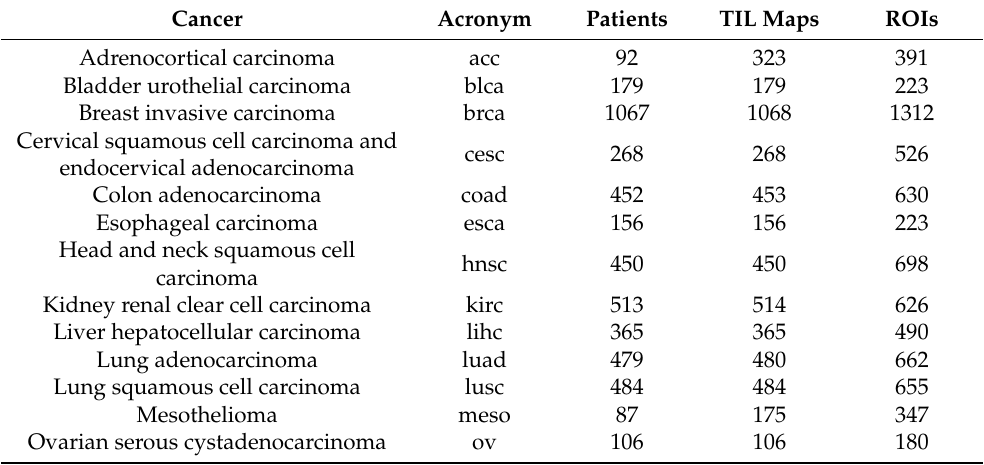
Table 1. Data description. TIL maps represent original images with TIL information, while regions of interest (ROIs) are tissue regions separated during the data-preprocessing step. One or more TIL maps were available per